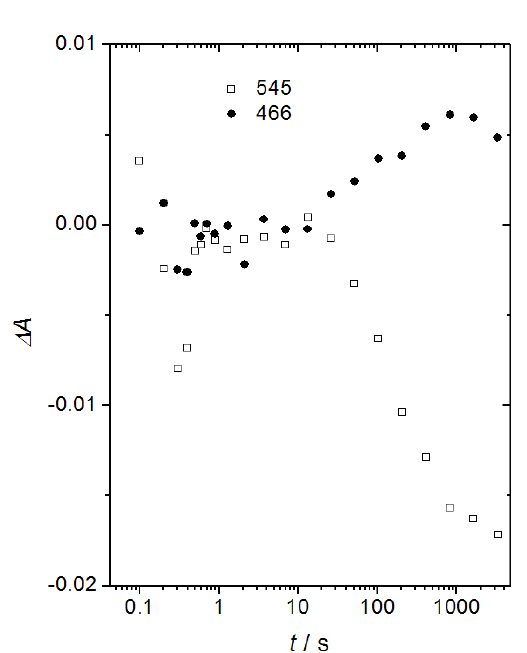
the measurement denote that from the n th measured spectrum (n-1) th spectrum was subtracted. Due to the arbitrary chosen times the numbered time-difference spectra represented: 1: A - A ; 2: A - A ; 14: A - A ; 18: A - A ; ( t = 0 s) ( t = - 0.1 s) ( t = 0.1 s) ( t = 0 s) ( t = 13.3 s) ( t = 6.9 s) ( t = 205.3 s) ( t = 102.9 s) A of the time difference spectra were calculated as following: 17: A 22: A - A - A ; 18: A - A ; ( t = 3277.3 s) ( t = 1638.9 s) b. Δ ( t = 102.9 s) ( t = 51.7 s) ( t = 205.3 s) ( t = 102.9 s) 19: A - A ; 20: A - A ; 21: A - A ; 22: A - A . ( t = 410.1 s) ( t = 205.3 s) ( t = 819.7 s) ( t = 410.1 s) ( t = 1638.9 s) ( t = 819.7 s) ( t = 3277.3 s) ( t = 1638.9 s)